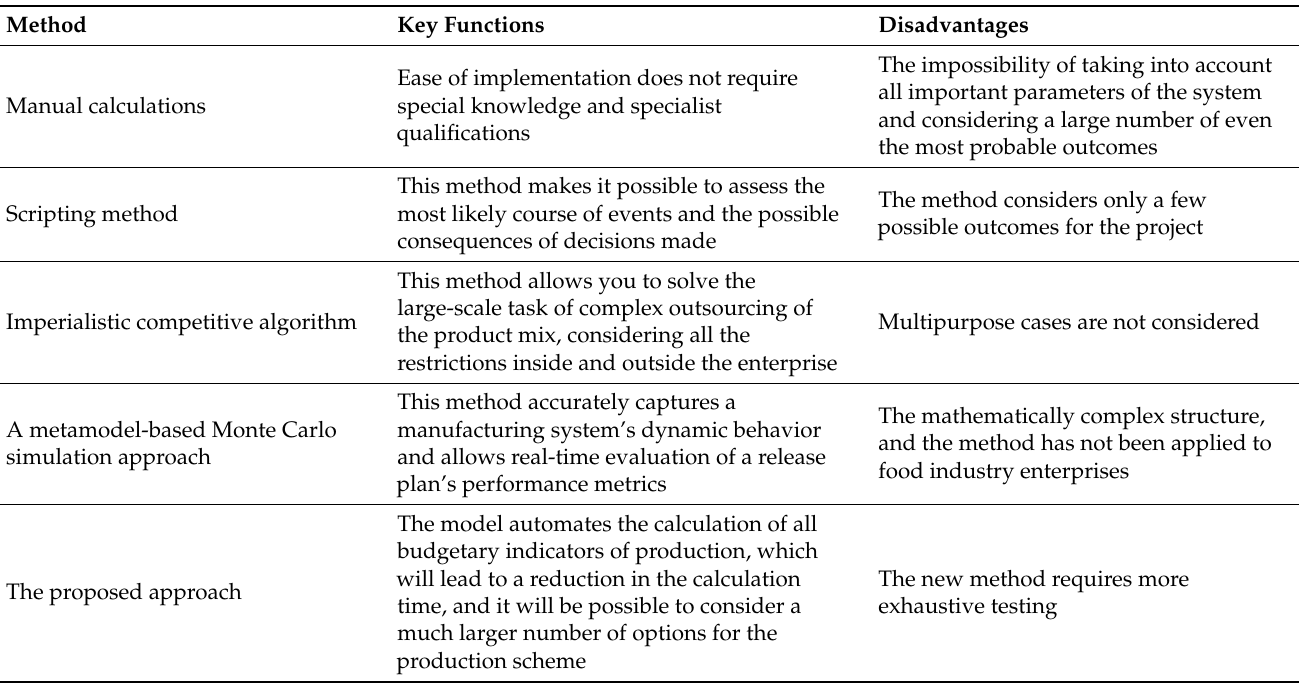
Table 1. Comparison of the optimization methods potentially applicable to the